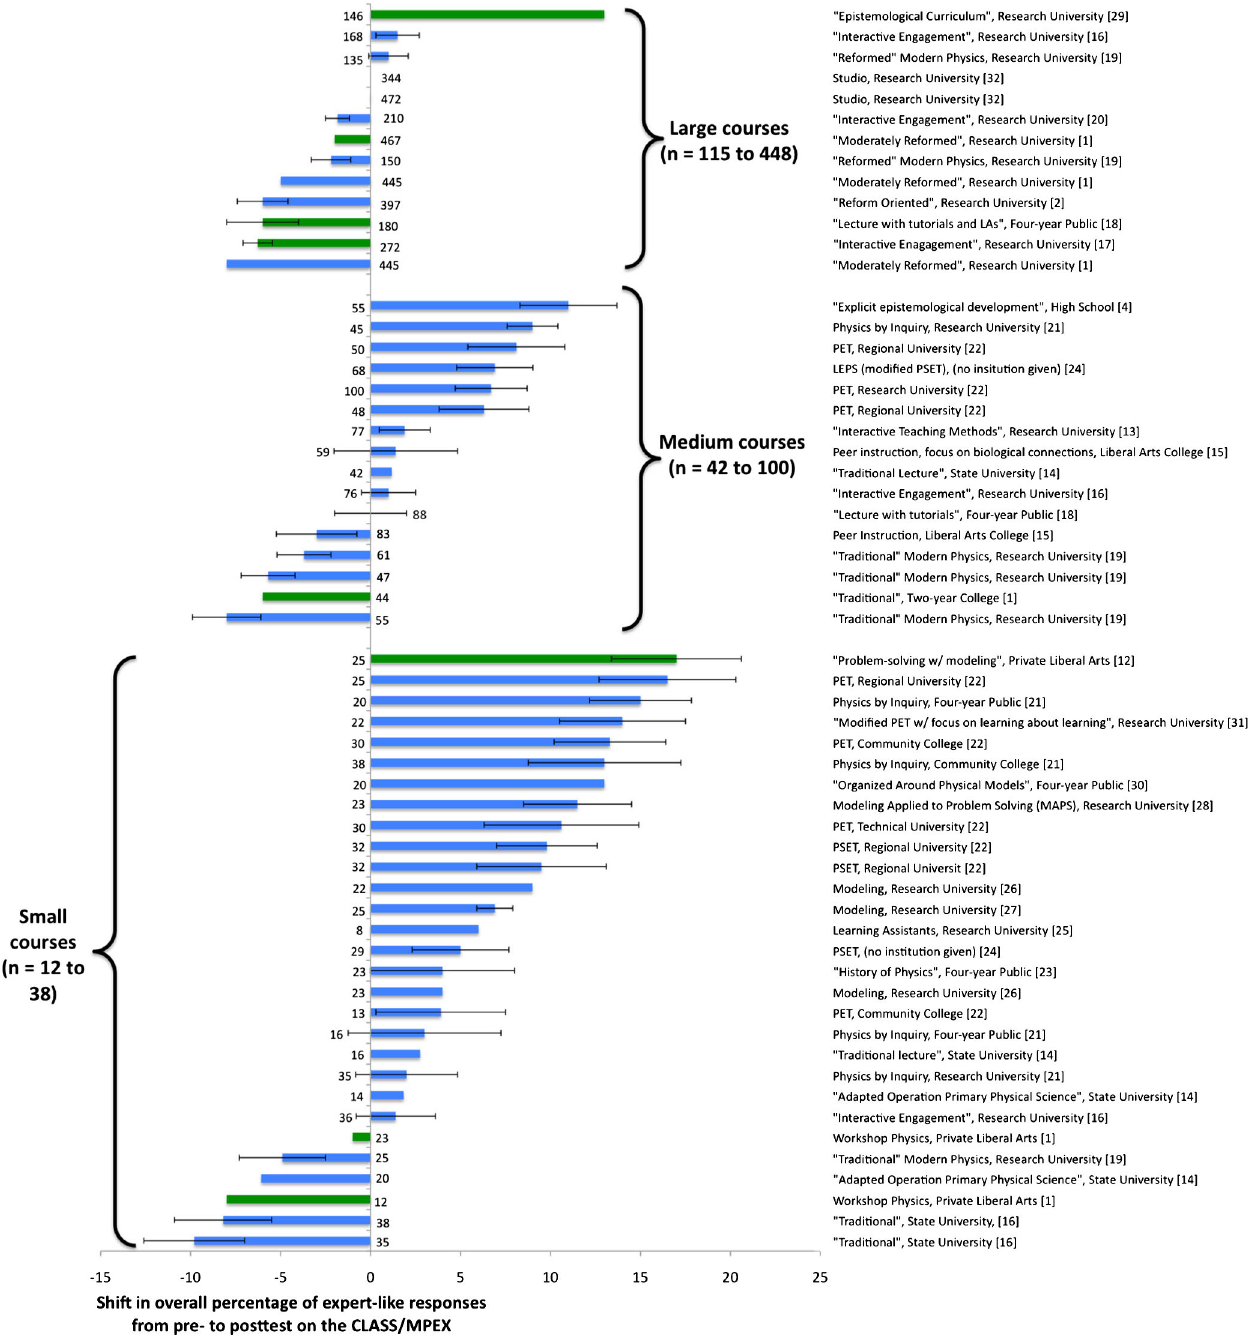
FIG. 3. Shifts in CLASS or MPEX by class size. The average shift for small classes is positive and for large classes is negative. There is a bar for each unique course at a given institution taught with a given teaching method. In the case of the same course taught for multiple semesters, we used a weighted average to combine the results and display as a single bar. The total number of students is used as the class size for large lecture courses where students attended smaller lab or recitation sections. There were several studies where the total number of students and number of course sections were reported. Here we found the average class size by dividing the total number of students by the number of